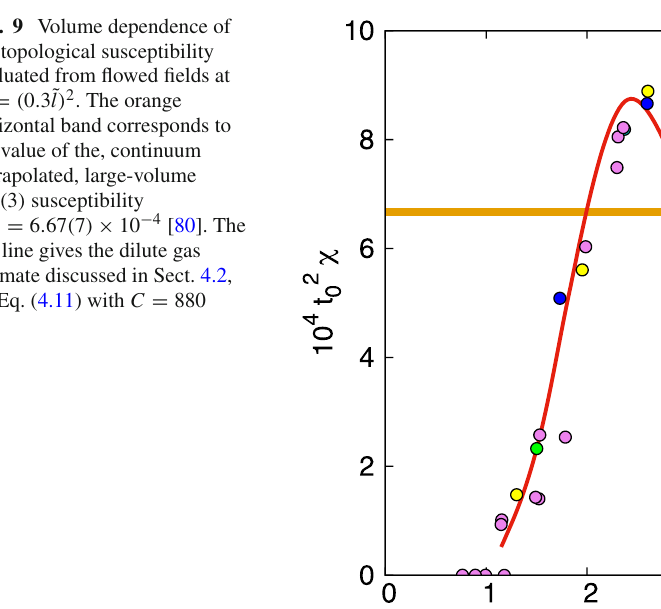
the topological susceptibility evaluated from flowed fields at 8 t = ( 0 . 3 ˜ l ) 2 . The orange horizontal band corresponds to the value of the, continuum extrapolated, large-volume SU ( 3 ) susceptibility χ = 6 . 67 ( 7 ) × 10 − 4 [80]. The t 2 0 red line gives the dilute gas estimate discussed in Sect. 4.2,